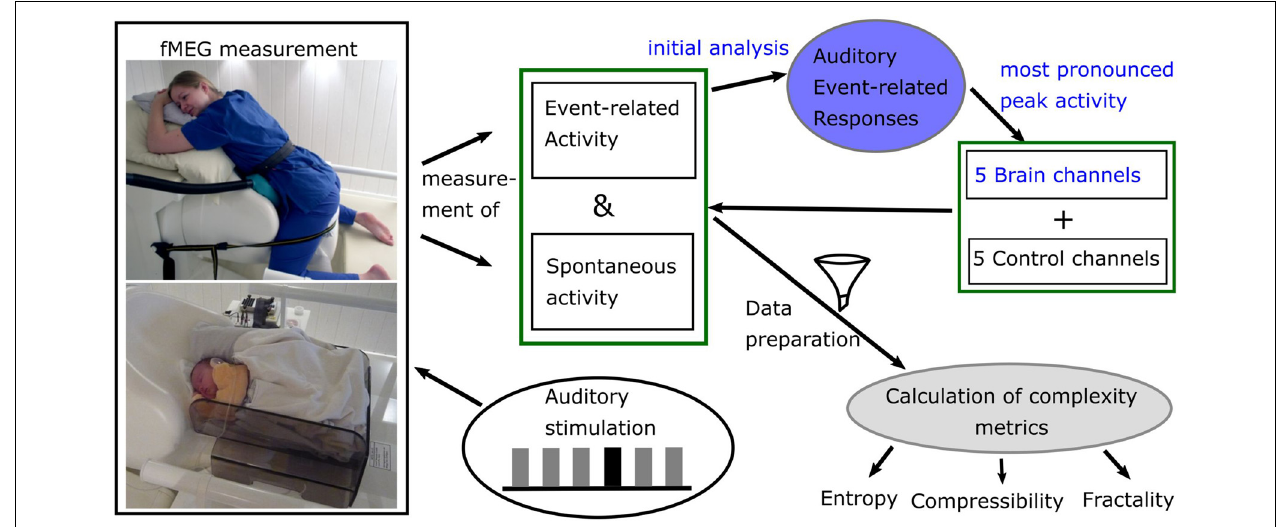
FIGURE 1 | Diagram of data acquisition and processing. Blue: analysis done for previous studies. Picture courtesy (left): University Hospital Tuebingen; written informed consent for publication was obtained by subject (top) and caregivers (bottom).